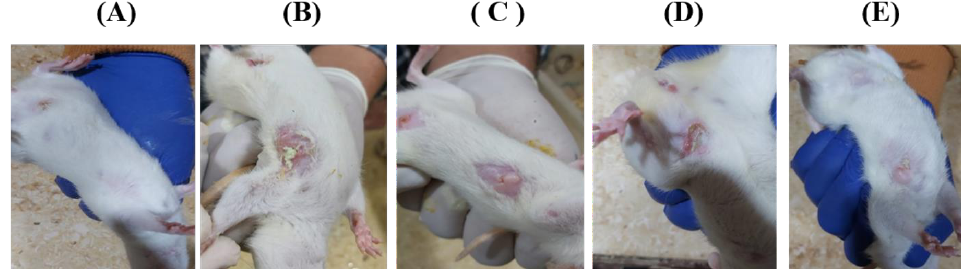
Figure 6. Photographs of the treated rats, including normal rat ( A ), untreated tumor-induced rat ( B ), and the various treated groups ( C – E ), including 5-FU/MTX saline solution injected group ( C ), the drug-loaded hydrogel system A ( D ), and the drug-loaded gel system C ( E ).